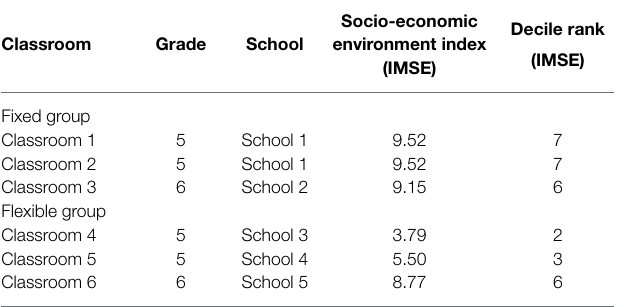
TABLE 2 | Socio-economic environment index (IMSE) and decile rank for each school in the sample.